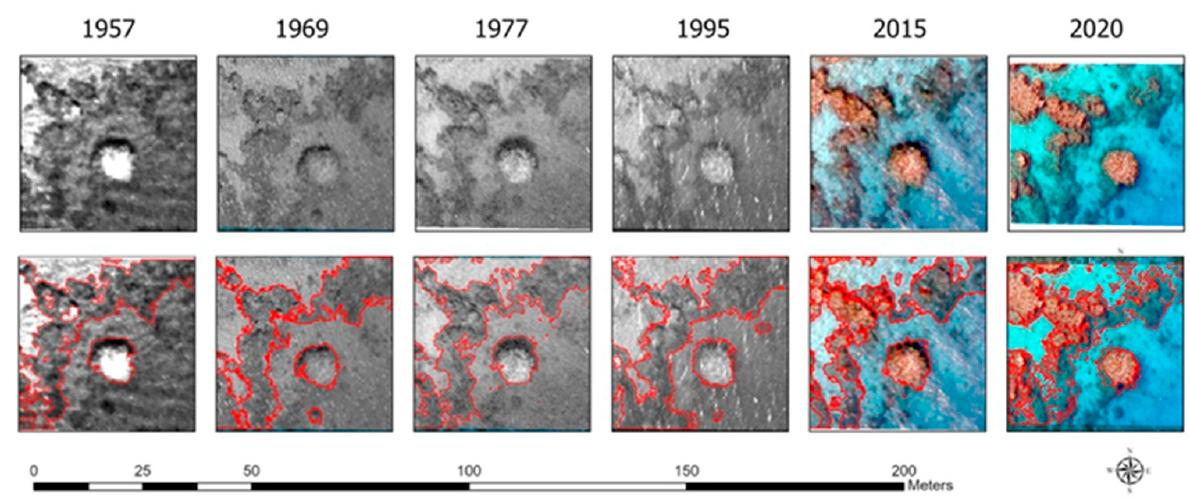
Figure 3. A segment of the coral reef located within the reserve (location marked by white arrow in Figure 2), as observed in historical aerial images taken between the years 1957 and 2015, and in a drone-based image taken in 2020. Red contour in the lower panels delineates the border of the reef, as identified in each image.